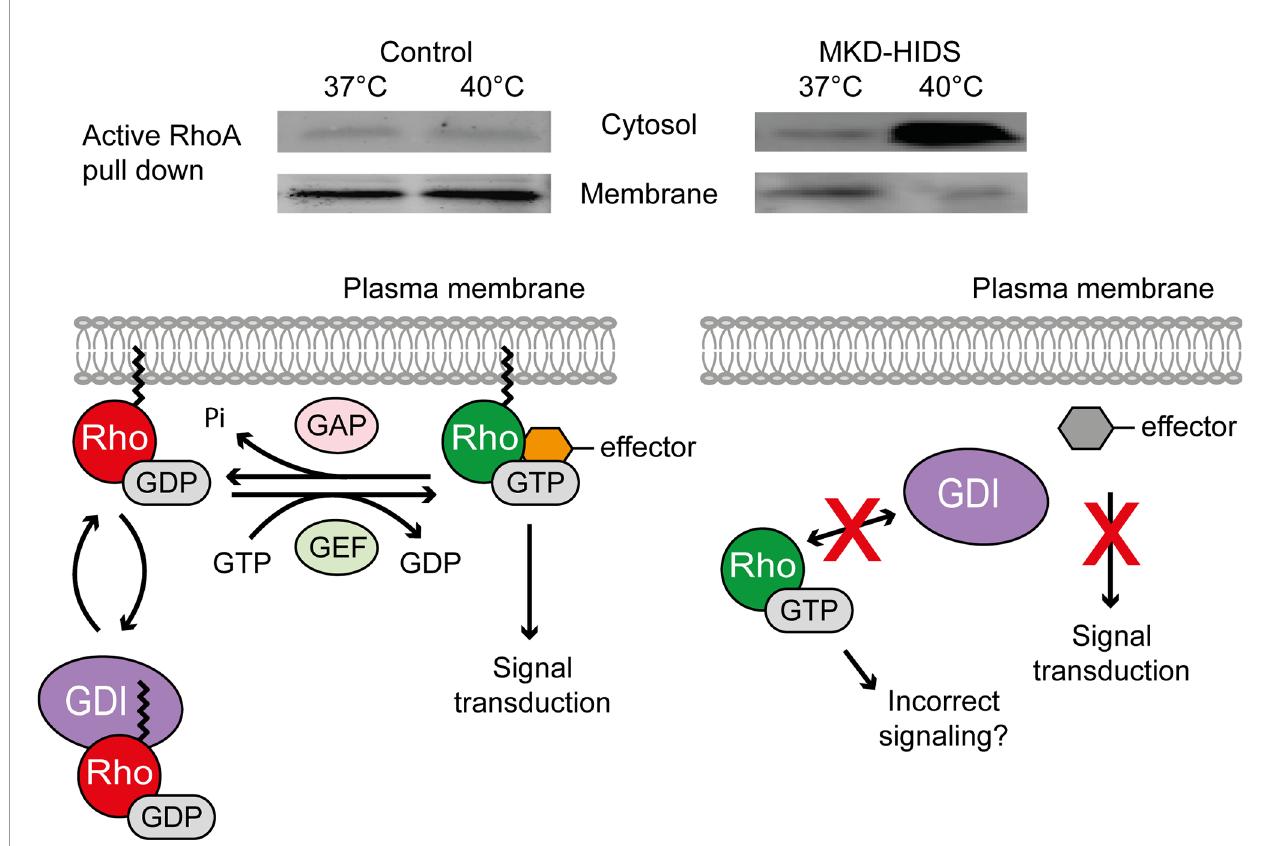
FIGURE 2 | Effect of temperature on the activation and localization of the small GTPase RhoA in MKD. Switching cells of MKD patients from 37°C to 40°C leads to GGPP depletion affecting protein geranylgeranylation and causing ectopic activation of the small GTPase RhoA. Guanine nucleotide dissociation inhibitor (GDI), guanine nucleotide exchange factor (GEF), GTPase activating protein